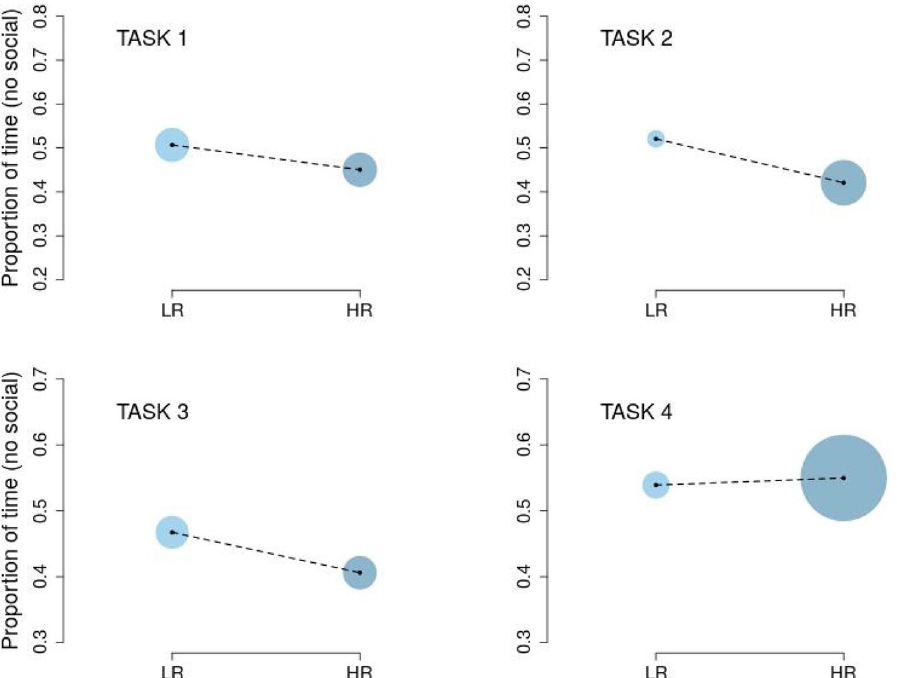
Figure 3. Estimated proportions (small black circles) and dispersion (big colored circles) of time fixation to non-social stimuli for all the tasks and both LR and HR groups. Note that dotted lines between mean points are drawn to highlight the increasing/decreasing levels of both groups and do not indicate any linear trend. Task 1: Inverted vs. upright face-like pattern. Task 2: Averted vs. direct eye-gaze. Task 3: Random motion vs. biological motion pattern. Task 4: Rigid motion vs. biological motion